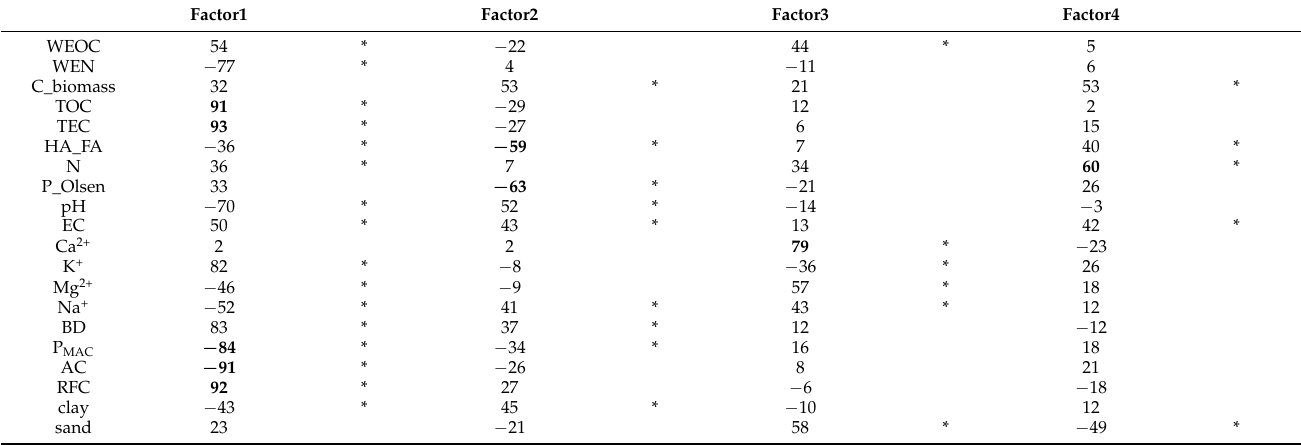
Table 5. Variable loadings of the first four components in the analysis carried out on the whole dataset. Values are multiplied by 100 and rounded to the nearest integer. Variance explained: PC1